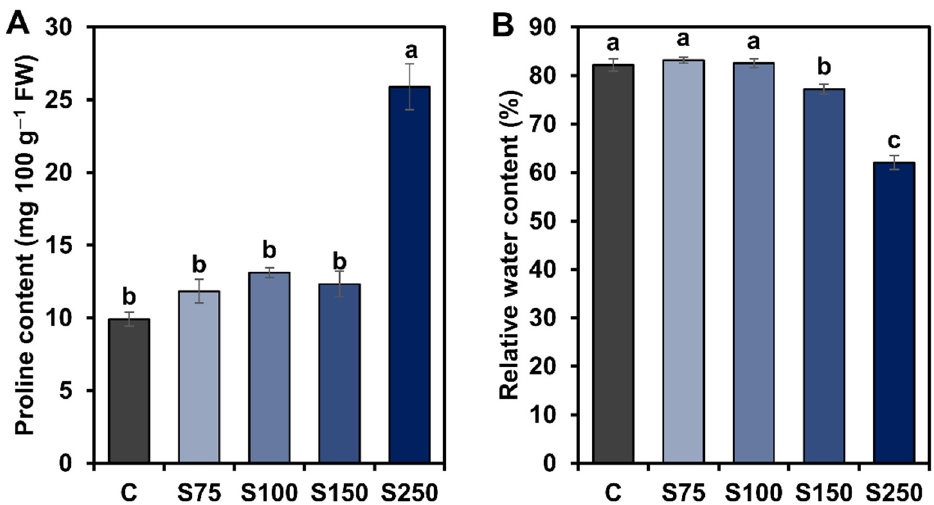
Figure 1. Effects of soil salinity on leaf proline content ( A ), and relative water content (RWC) ( B ) in sugar beet after exposed to various salt concentrations for 95 days. Each bar represents the average of three independent replicates ( n = 3), and the error bar denotes standard errors. Statistically significant differences among different treatments are designated by various alphabetic letters based on Tukey's honestly significant differences test ( P < 0.05 ). Control (C), 0 mM NaCl; S75, 75 mM NaCl; S100, 100 mM NaCl; S150, 150 mM NaCl; S250, 250 mM NaCl.